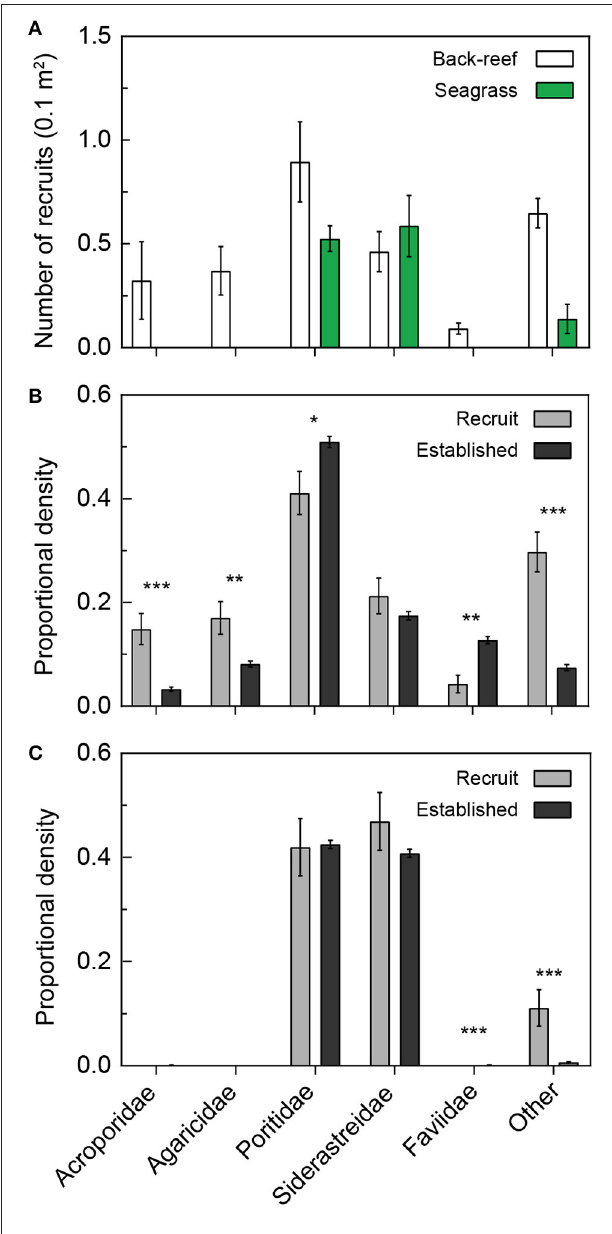
FIGURE 5 | Recruitment of corals into back-reef and seagrass habitats relative to the established population. Number of coral recruits (0.1m 2 ) on settlement tiles (A) located in back-reef (white bars) and seagrass (green bars) habitats pooled across 2012 and 2013. Coral recruits (gray bars) are compared to the respective proportions of established corals (dark gray bars) within the same families in back-reef and seagrass habitats in (B,C) , respectively. Significant differences between the proportions of established and recruited corals are denoted by asterisks, specifically p < 0.05 (*), < 0.01(**), and < 0.001 (***).